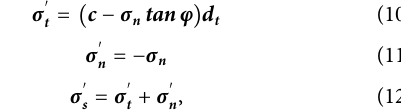
FIGURE 4 Sketch of safety factor solving by vector sum